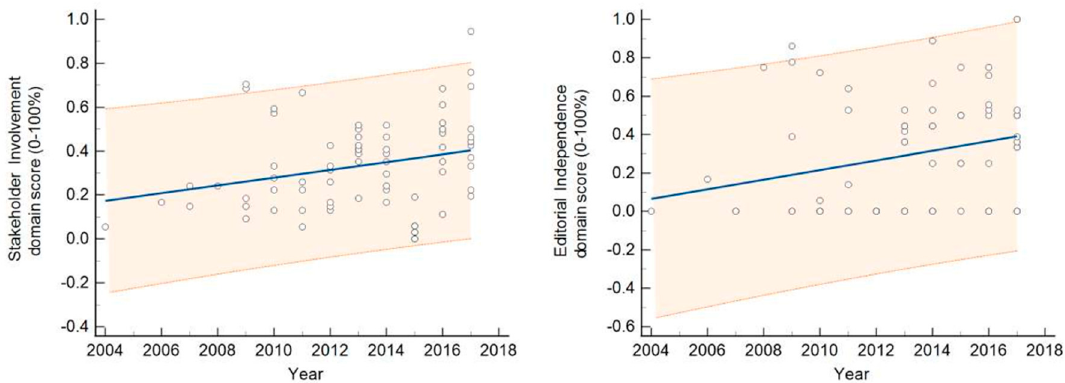
Figure 3. Croatian guidelines’ AGREE II scores in the domains “stakeholder involvement” and “editorial independence” increased over time. Shown here are the individual scores, as well as the simple regression line and its accompanying 95% prediction interval.